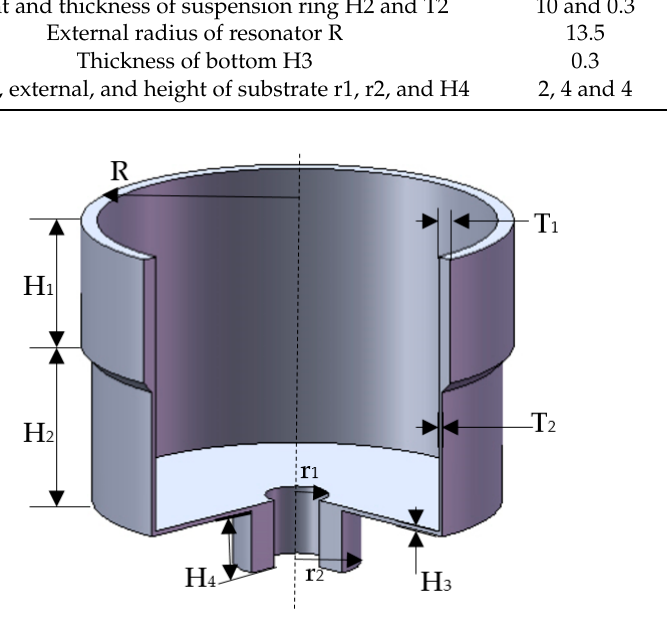
Figure 3. The resonator model.